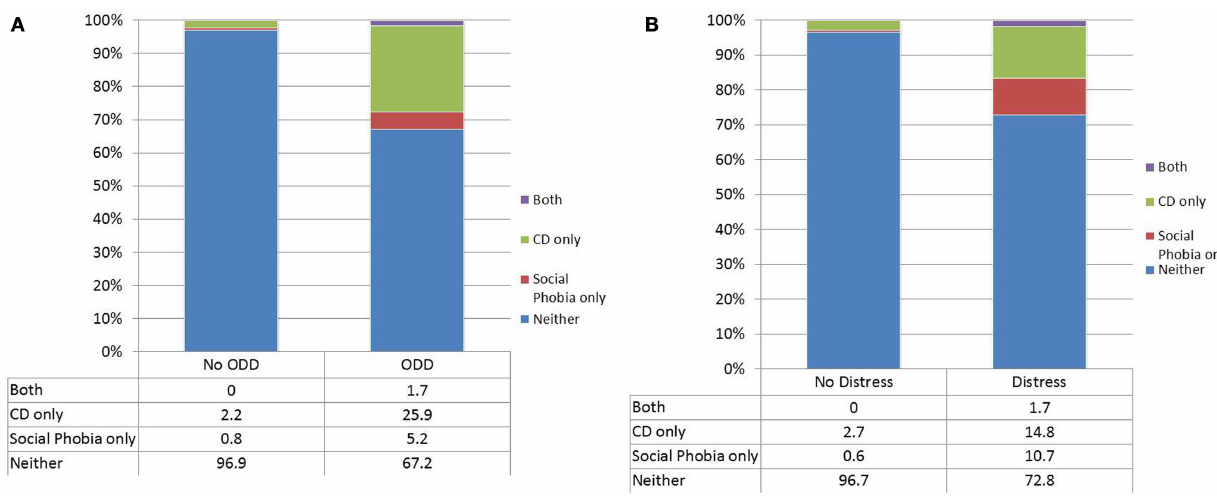
FIGURE 1 |The overlap between conduct disorder and social phobia as a function of either oppositional defiant disorder (A) or the distress disorder category (B) .